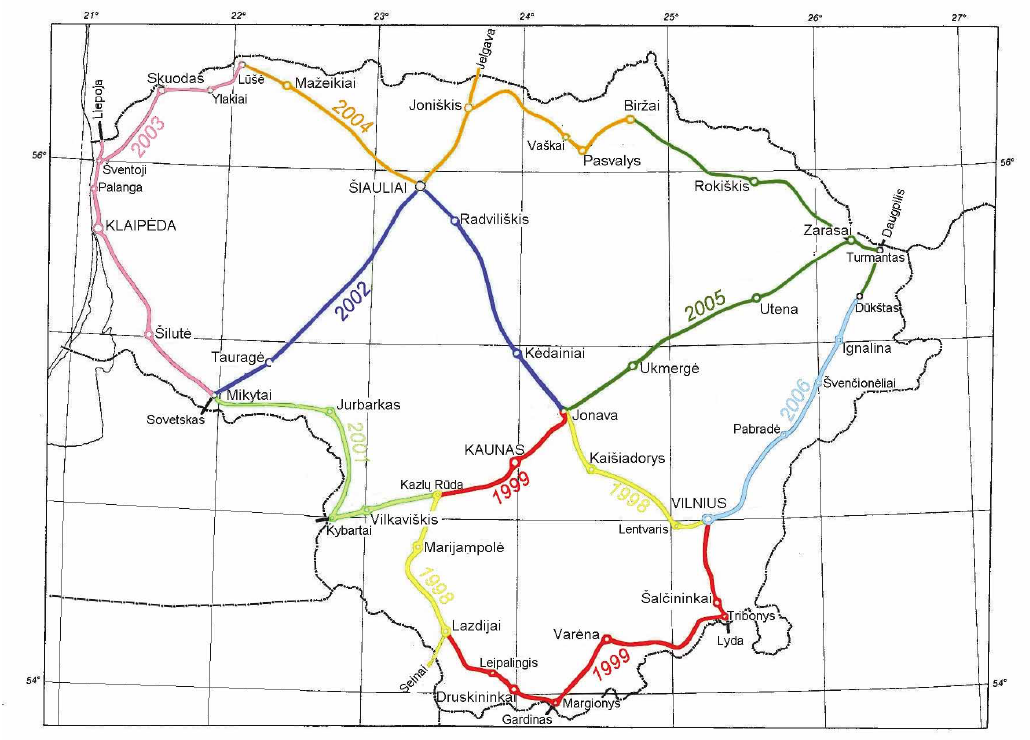
Fig. 2. The first order levelling lines of the Lithuanian NGVN and years of field